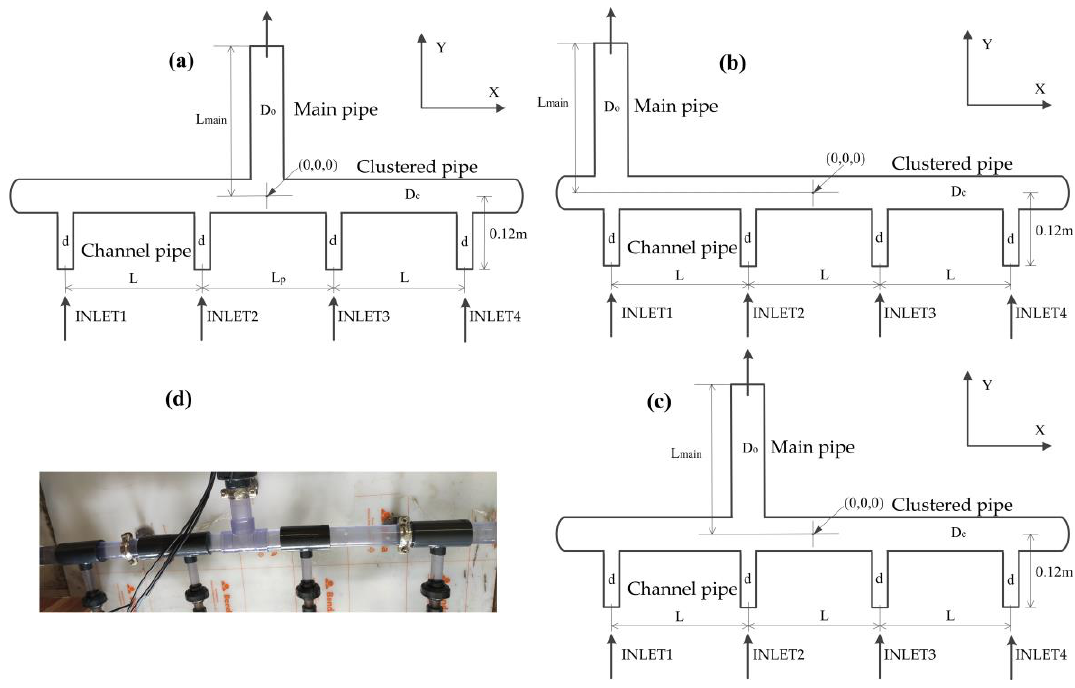
Figure4. Di ff erentschemaofthestructure: ( a )configuration“A”; ( b )configuration“B”; ( c )configuration Figure 4. Different schema of the structure: ( a ) configuration “A”; ( b ) configuration “B”; ( c ) “C”; ( d ) physical objects of configuration “A”. configuration “C”; ( d ) physical objects of configuration “A”. Table 2. Design details of configuration Table 2. Design details of configuration “A”.